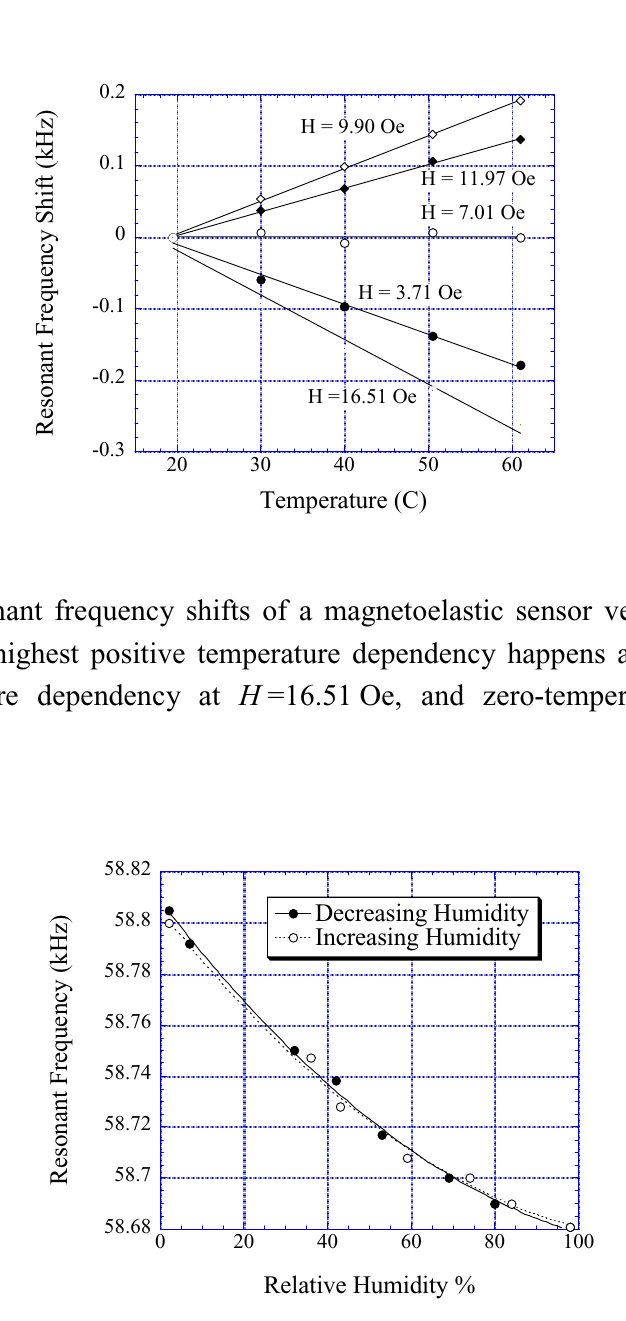
Figure 10. The resonant frequency shift of a TiO -coated humidity sensor as a function of 2 coating changes mass in response to humidity level, in turn humidity concentration; the TiO 2 shifting the resonant frequency of the